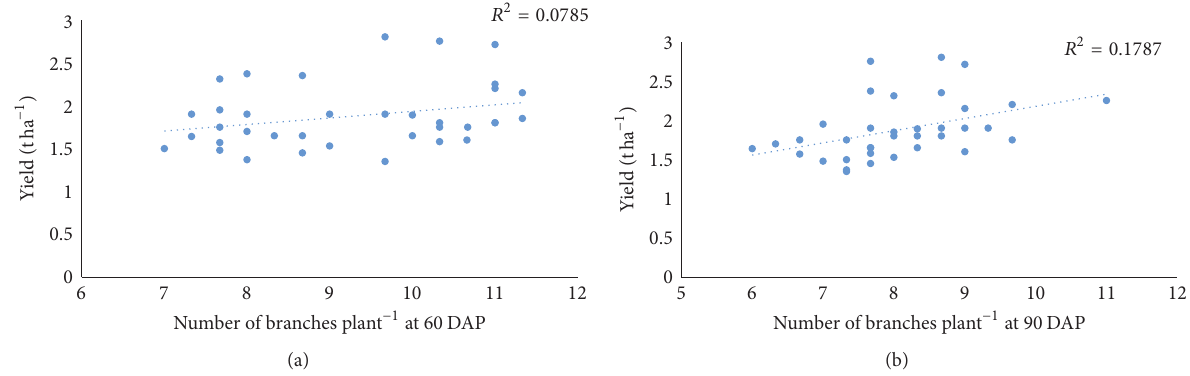
Figure 3: Relationship between days to 50% flowering and number of branches/plant at 30 DAP with yield of peanut (mean of two trials).